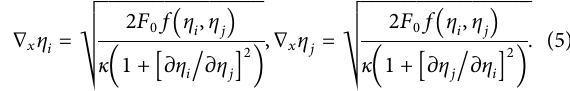
parameters used for phase- fi eld simulations are summarized